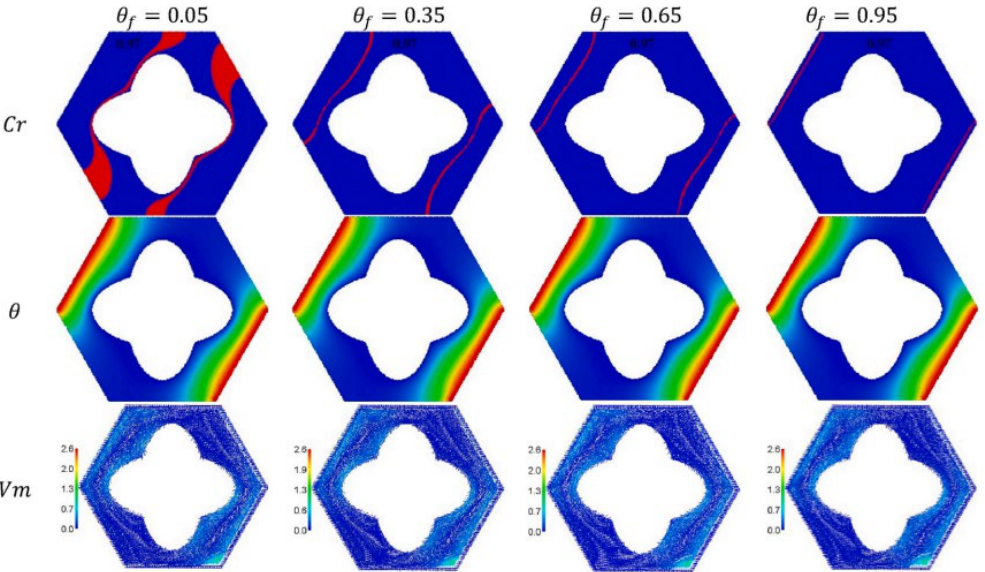
Figure 20. Under changing fusion temperatures θ f , velocity field, the heat capacity, and isotherms. Reprinted with permission from Ref. [41]. 2021, Elsevier.